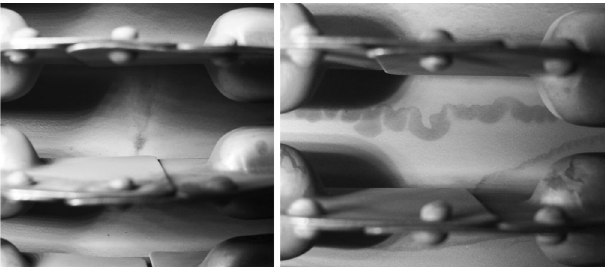
(right).FIG. 12. Two examples of arc track marks in accelerating tubes which did not exhibit any surface leakage after applying a 6 kV test voltage across the gap between titanium